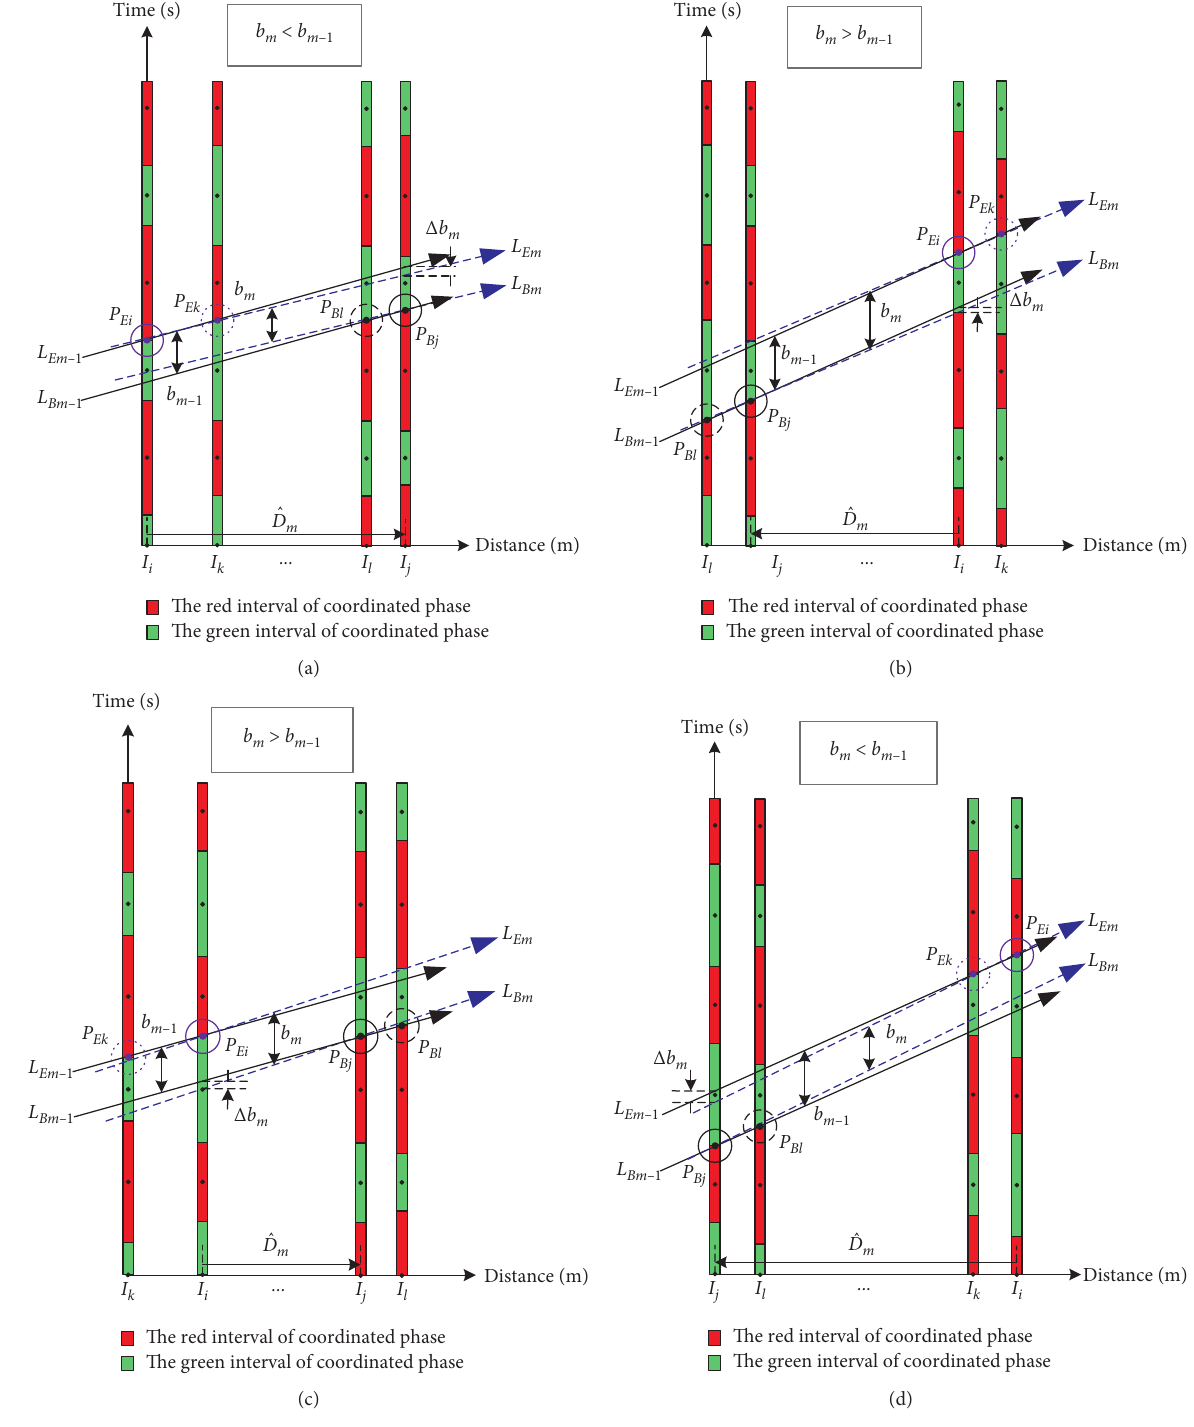
􏽣 D V ( 2 ,m ) > ( 2 ,m − 1 ) and m > 0.